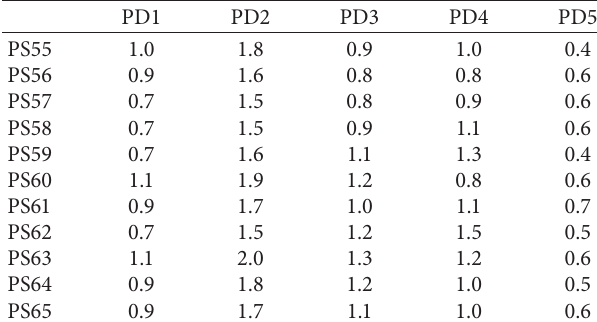
Table 4: Transportation times between facilities in the petrol re- plenishment network